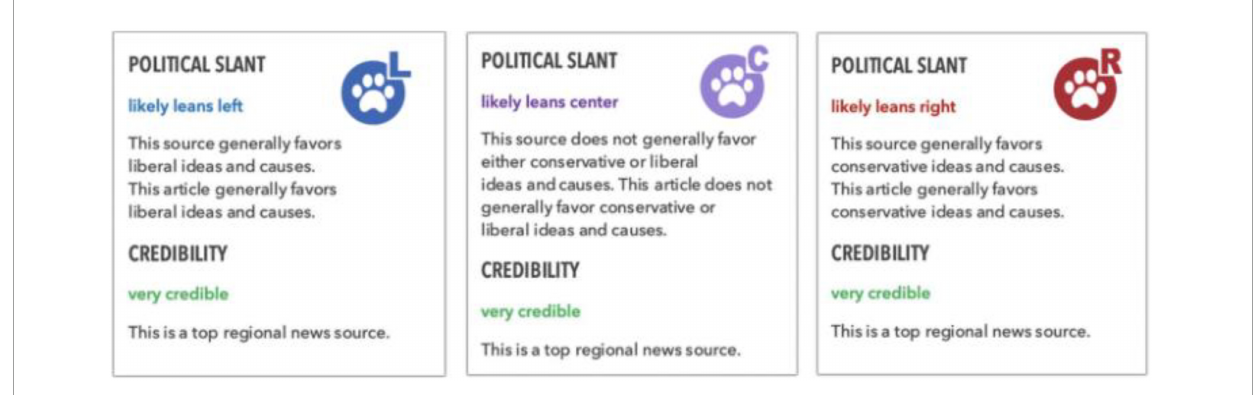
FIGURE1 Sample bias indicators used in Study 1 and 2. Reproduced with the permission of NoBias, LLC.